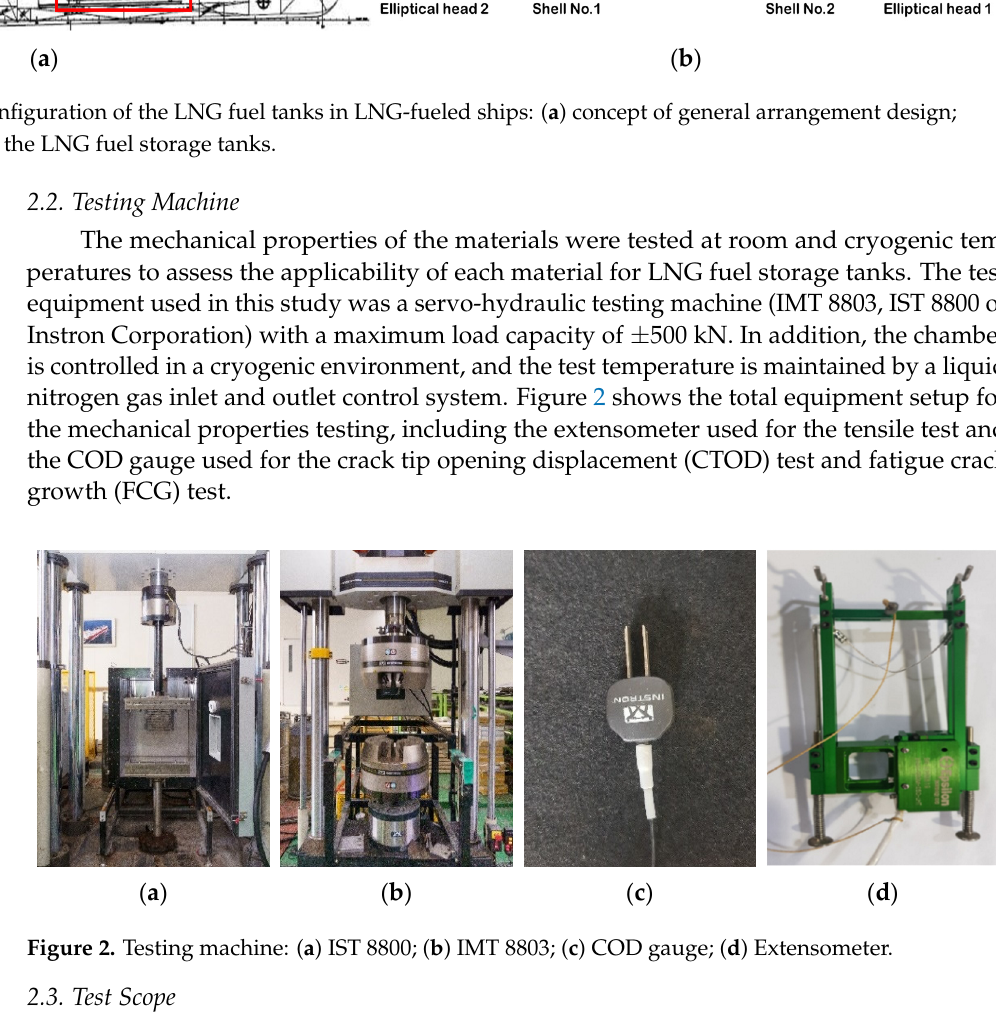
Figure 1. The welding configuration of the LNG fuel tanks in LNG-fueled ships: ( a ) concept of general arrangement design; ( b ) schematic diagram of the LNG fuel storage tanks. Table 3. Welding parameters of weld metals.